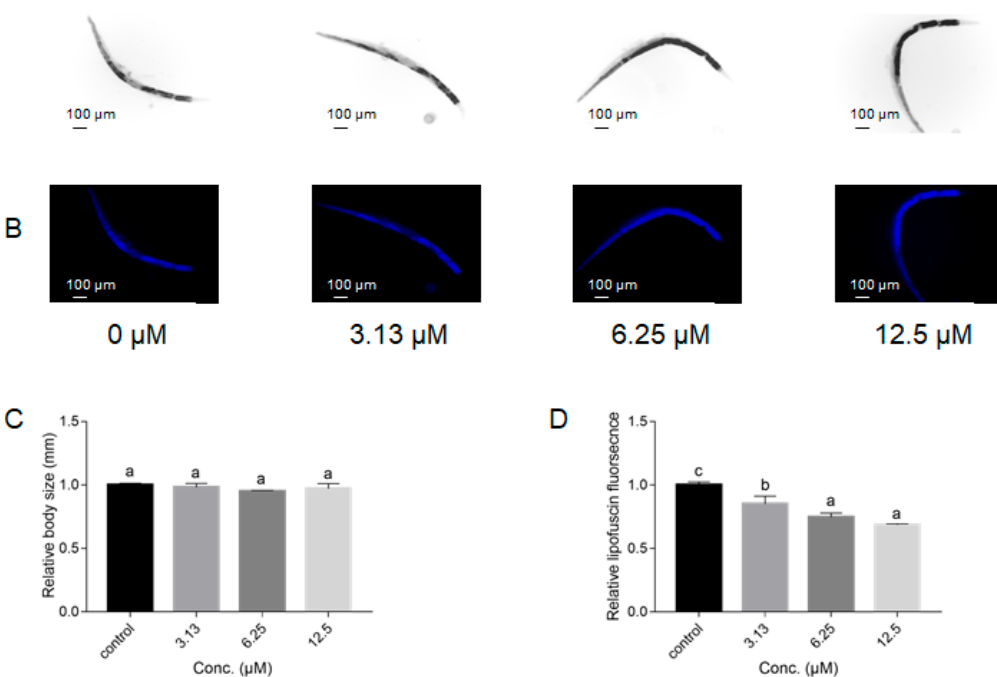
Figure 4. E ff ect of NOB on body size and lipofuscin accumulation in C. elegans . Wild-type N2 animals were treated without or with 3.13, 6.25, and 12.5 µ M NOB for five days at 20 ◦ C. The body size and lipofuscin accumulation were measured using fluorescence microscope, and the results are presented at ( A , B ). Body length and lipofuscin were quantitated by Image J software ( C , D ). Bars with di ff erent letters indicate statistical significance ( p <